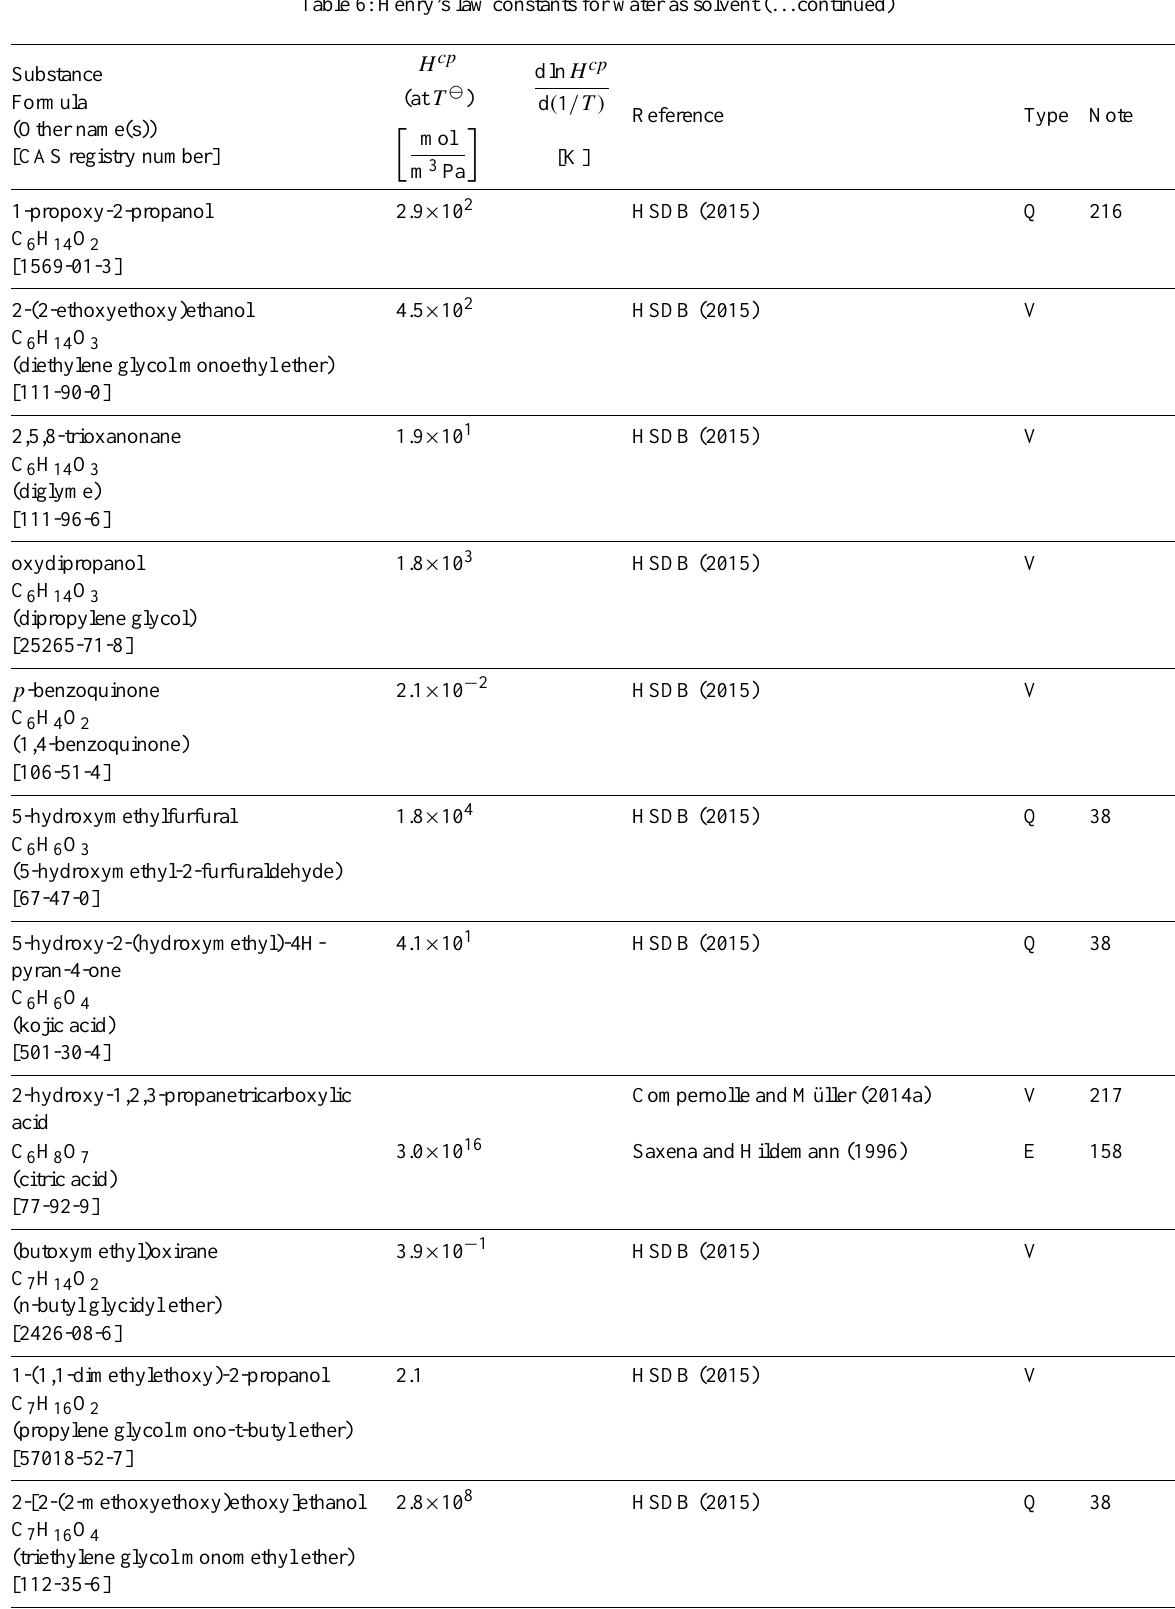
Table 6: Henry’s law constants for water as solvent